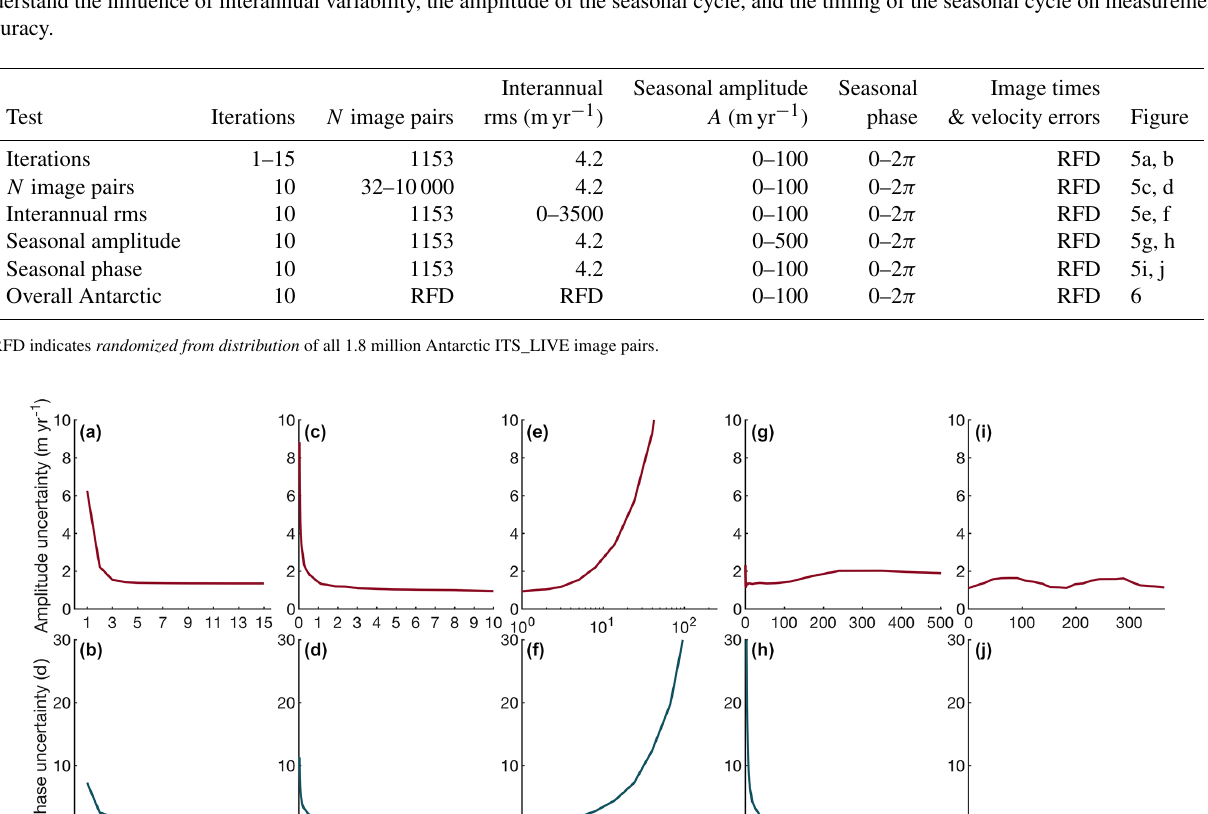
Table 1. Sensitivity test parameters. To understand how various factors influence measurement sensitivity, we isolate and vary a number of key characteristics of the synthetic time series and the data analysis method. In the first test, we vary only the number of iterations described in Sect. 3.3 to determine how many iterations are necessary to achieve a stable solution. We then test the effects of sampling velocity time series with 32 to 10000 synthetic image pairs. In the remaining tests, we prescribe characteristics of the synthetic velocity time series to understand the influence of interannual variability, the amplitude of the seasonal cycle, and the timing of the seasonal cycle on measurement accuracy.